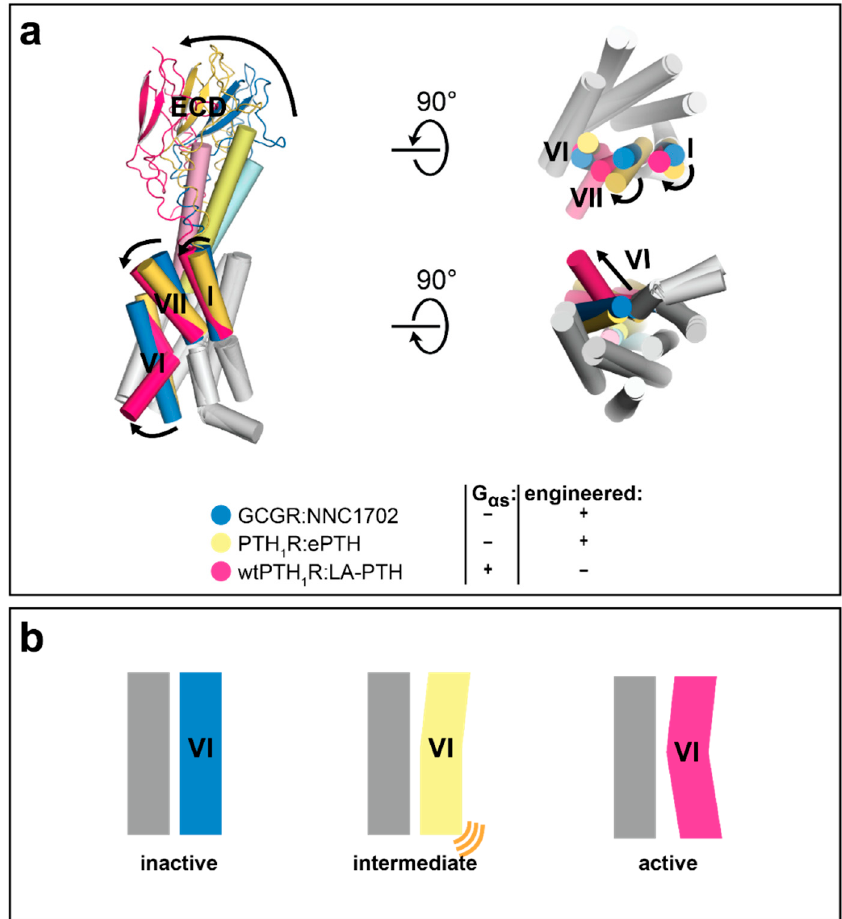
Figure 7. Crystal structure of engineered PTH 1 R is stabilized in an intermediate state. Conformational changes during class B receptor activation. ( a ) Superposition of GCGR (PDB ID: 5YQZ), PTH 1 R (PDB ID: 6FJ3), and wtPTH 1 β R:G α s (PDB ID: 6NBF). Transmembrane helices I, VI, and VII are highlighted in color. Conformational changes are indicated by black arrows. ( b ) Schematic overview of receptor conformational states. From left: inactive conformation with contracted intracellular and extracellular helix portions. Intermediate conformation with extracellular active-like expanded binding site, but only loosely expanded intracellular helix bundle (indicated by orange lines). Fully active state , indicated by expanded binding pocket and outward movement of intracellular ends of helix VI.